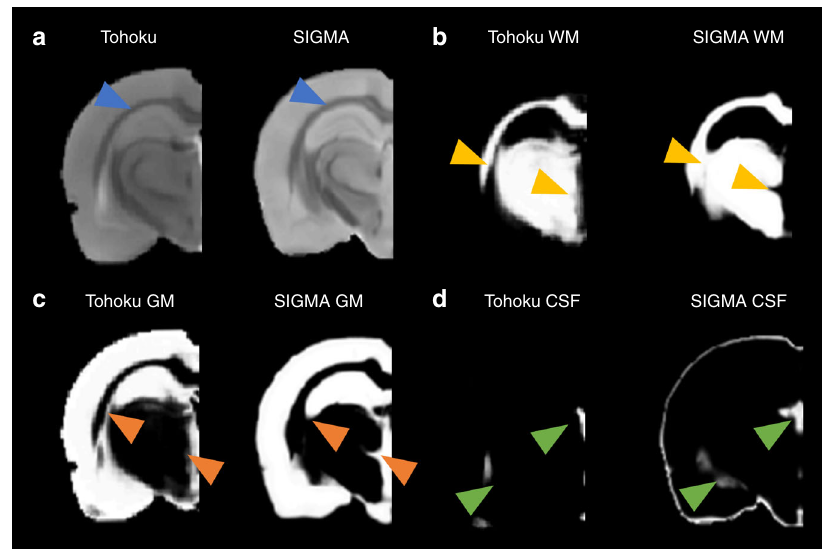
Fig. 2 Comparison between Tohoku and SIGMA templates and tissue probability maps. a Coronal views of the Tohoku (left) and SIGMA (right) anatomical template of rat brain at the same coordinates (Bregma: – 3.8 mm). Blue arrows indicate differences of corpus callosum shape between both templates. b Coronal views of the Tohoku (left) and SIGMA (right) White Matter (WM) probability maps at the same coordinates. Yellow arrows demonstrate differing classi fi cation of WM within the fi mbria of the hippocampus. c Coronal views of the Tohoku (left) and SIGMA (right) Gray Matter (GM) probability maps at the same coordinates. Orange arrows show the differences in GM classi fi cation within the fi mbria of the hippocampus. d Coronal views of the Tohoku (left) and SIGMA (right) Cerebrospinal Fluid (CSF) probability maps at the same coordinates. Green arrows show the differing CSF classi fi cation within the lateral